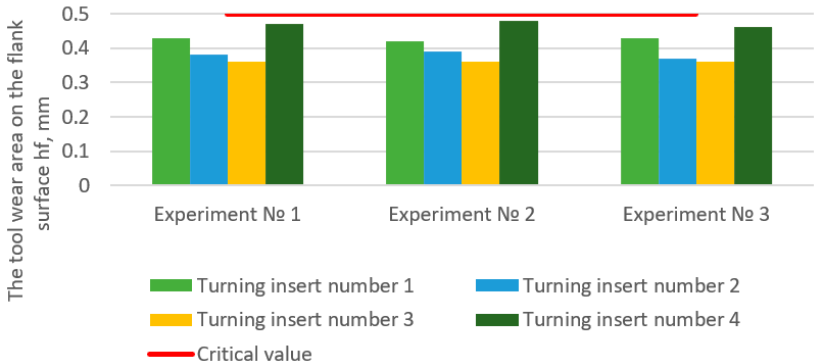
Figure 6. Results of a full-scale experiment with machining turning.